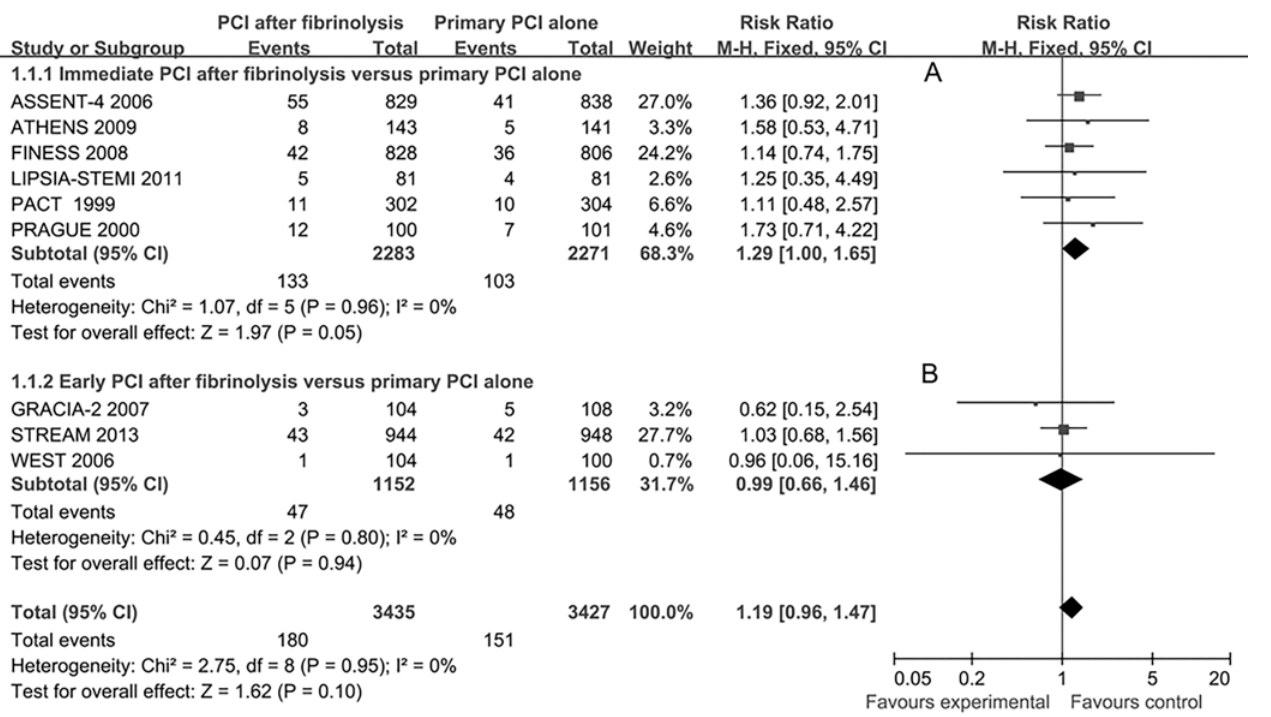
Fig 3. Short-term mortality for immediate or early percutaneous coronary intervention (PCI) after fibrinolysis versus primary PCI